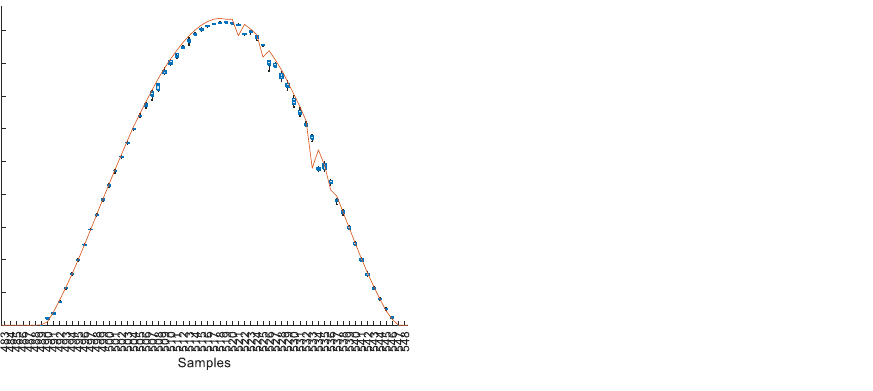
Figure 23. Solar Irradiance detail. Measured values (red) and one-step-ahead box plot of ε ( 25 ) PHMOGA M (blue).